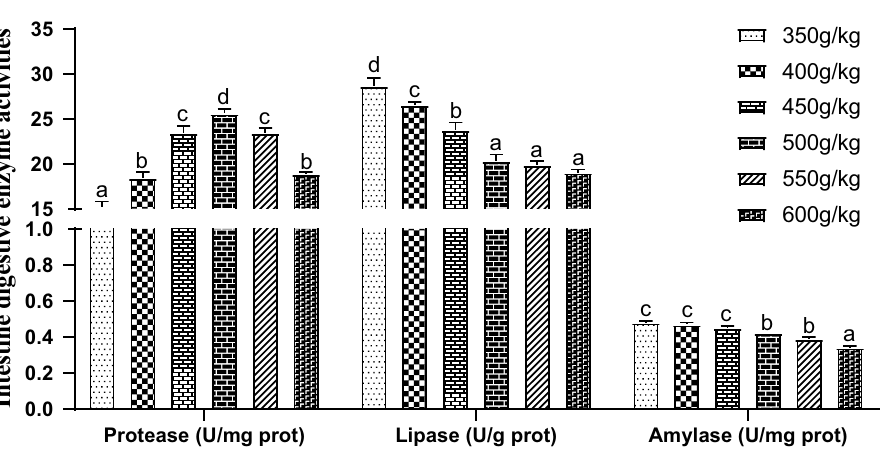
Figure 4. Effect of dietary protein level on intestine digestive enzyme activities of juvenile orange-spotted grouper. Values are means ± SD (n = 3). Different letters assigned to the bars represent significant differences using Duncan’s multiple comparison ( P <